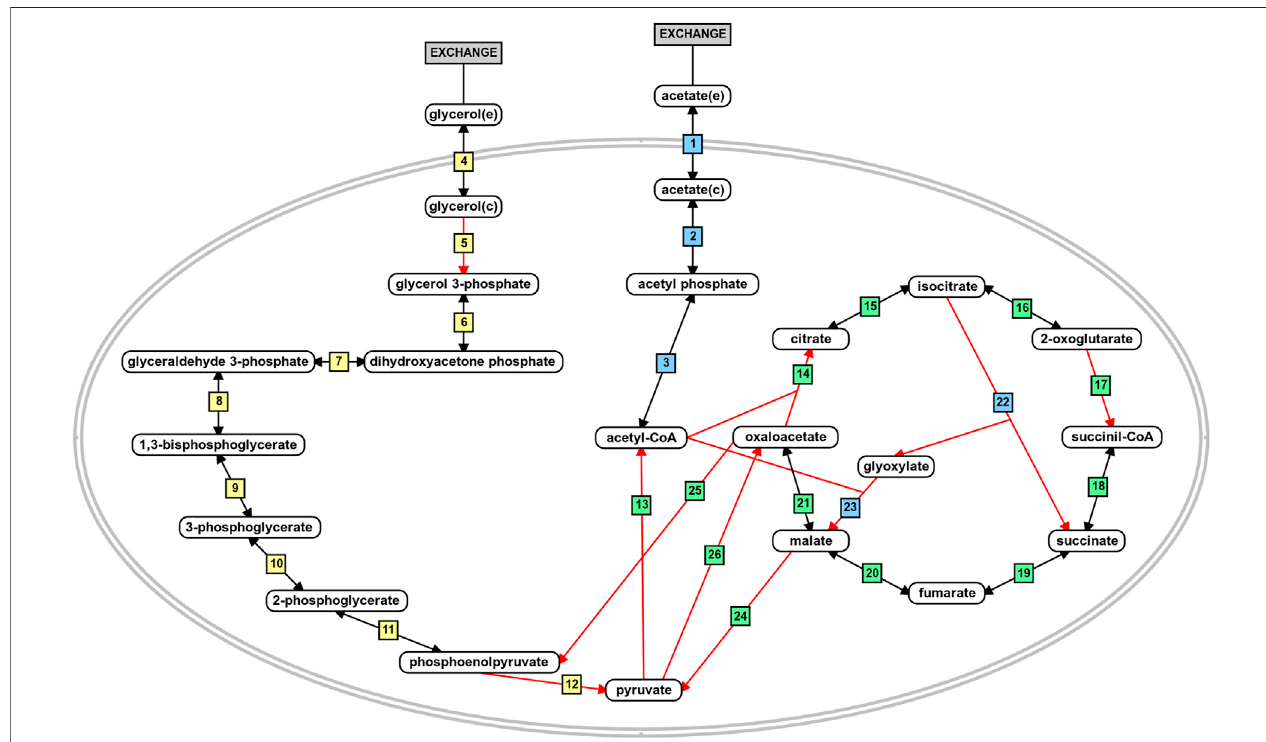
FIGURE 4 | Schematic representation of acetate and glycerol central metabolism in P. aeruginosa PAO1. The blue boxes depict reactions related to acetate metabolism.Theyellowboxesdepictreactionsrelated toglycerolmetabolism,andthegreenboxesarethereactions sharedbythemetabolismofbothcarbon sources. The red arrows indicate irreversible reactions. This fi gure was generated using the PathVisio software (Kutmon et al., 2015).